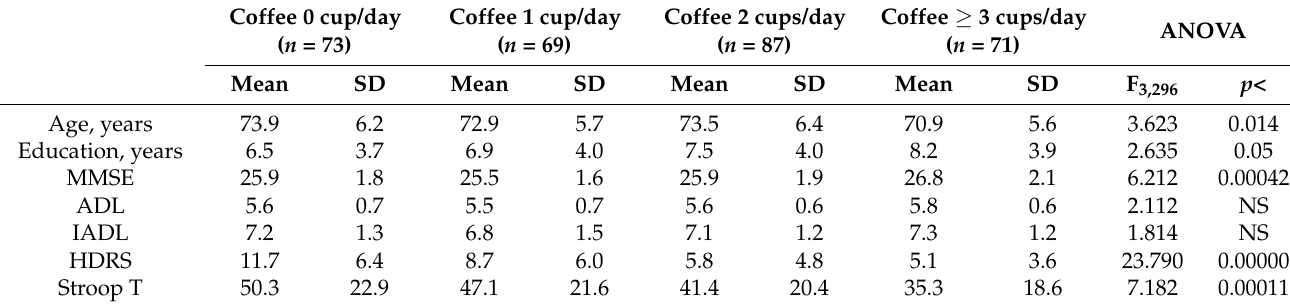
Table 1. Comparison of continuous variables obtained from the four groups of subjects.